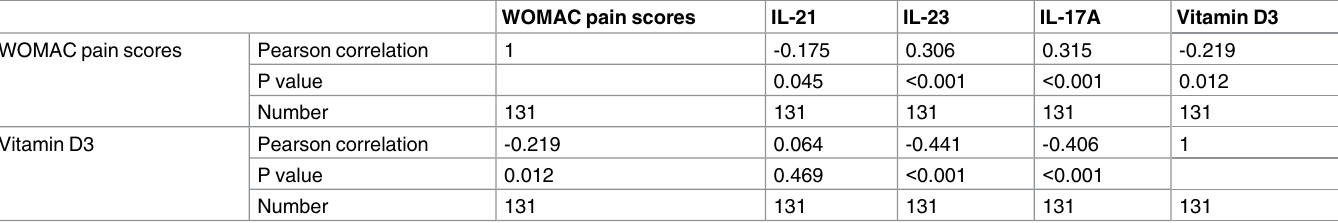
Table 3. Correlation between WOMAC pain scores, IL-21, IL-23, IL-17A and vitamin D3 in OA